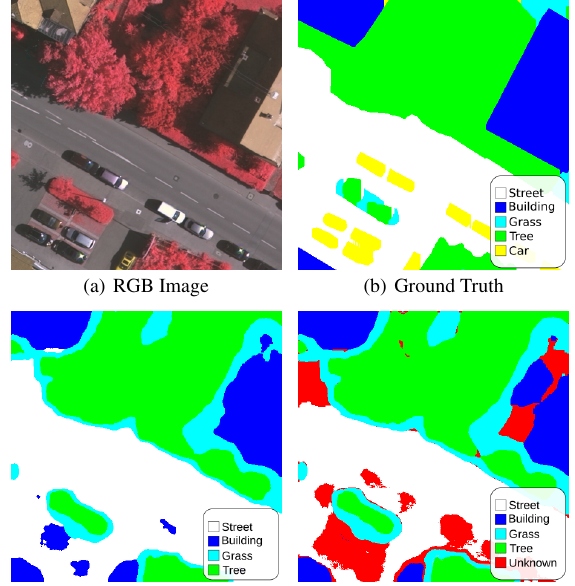
Figure 4. Per-class error rates for each unknown class according to the closed set baseline (a) and the proposed open set methods (b-c).